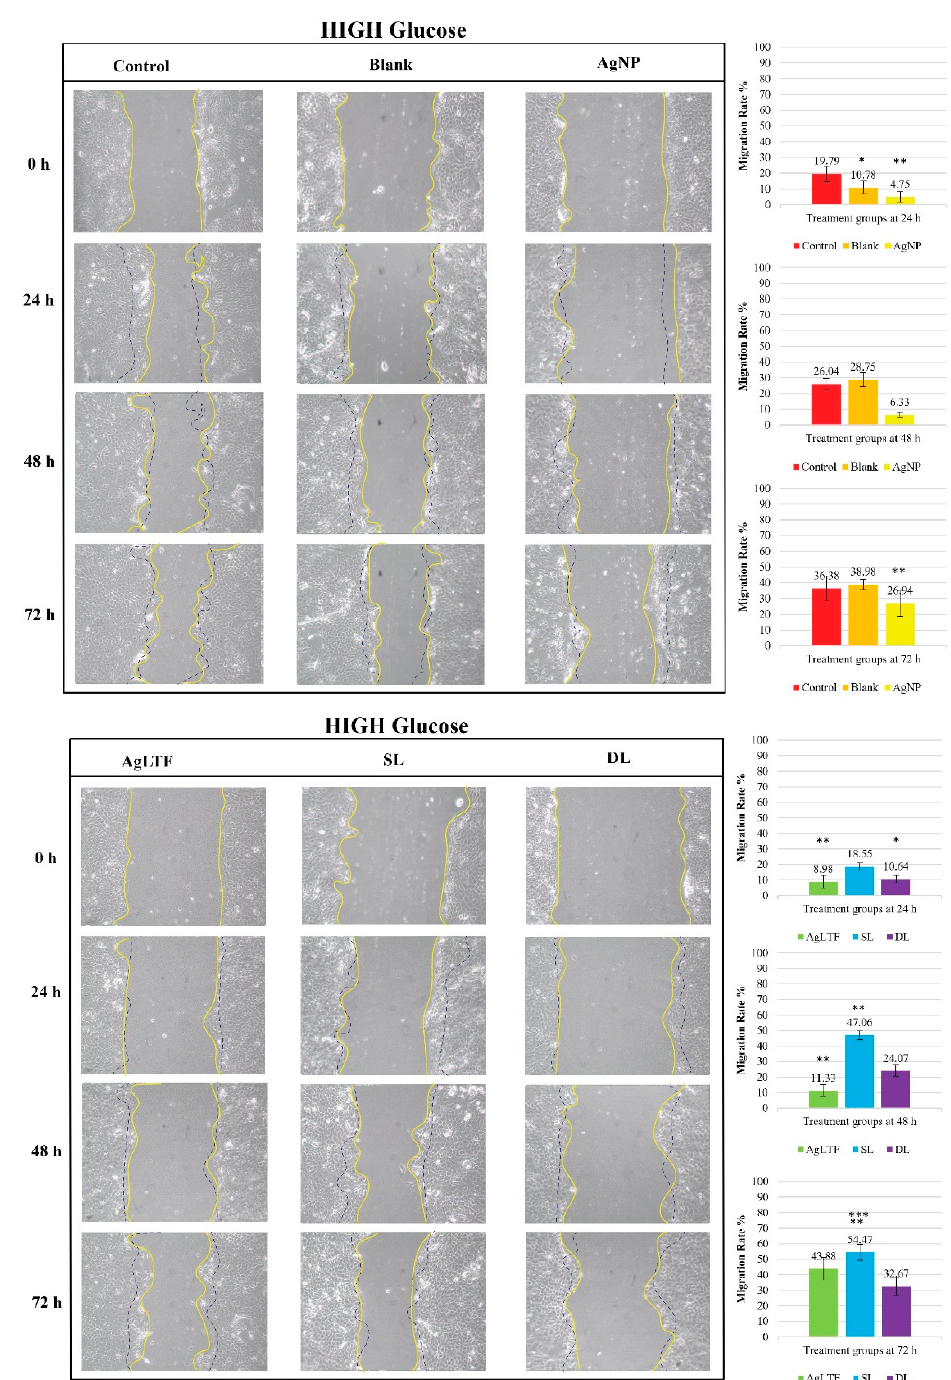
Figure 12. Wound scratch assay for control, blank, AgNPs, AgLTF, SL, and DL gels at time points 24, 48, and 72 h, n = 9. * statistically significant difference from the positive control ( p < 0.05); ** statistically significant difference from the positive control ( p < 0.01); *** statistically significant difference from AgLTF.